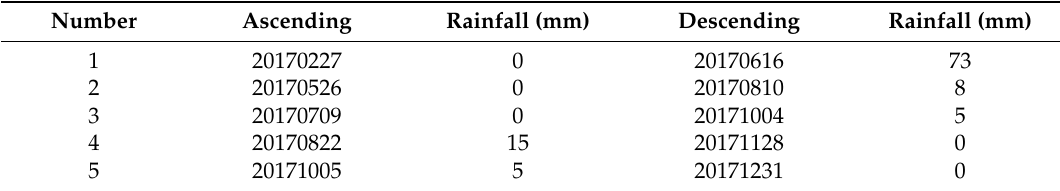
Table 3. The rainfall 24 h before the TSX-SL SAR acquisition.